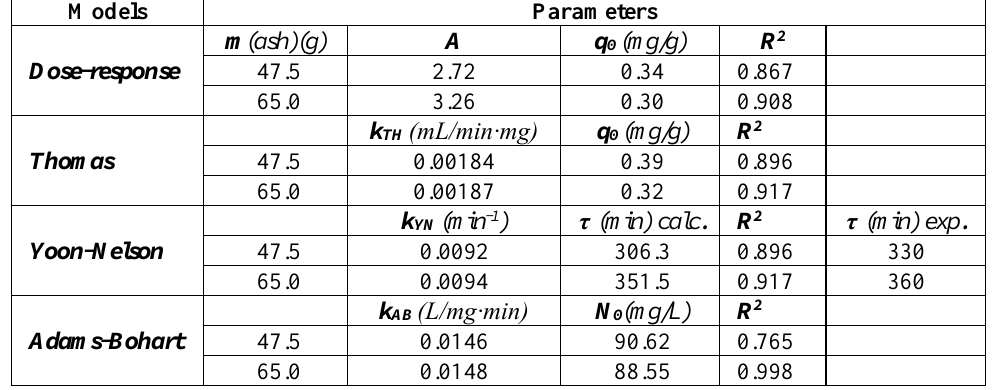
Table 5: Kinetics parameters in dynamic conditions for the adsorption of phenol on SBFA.